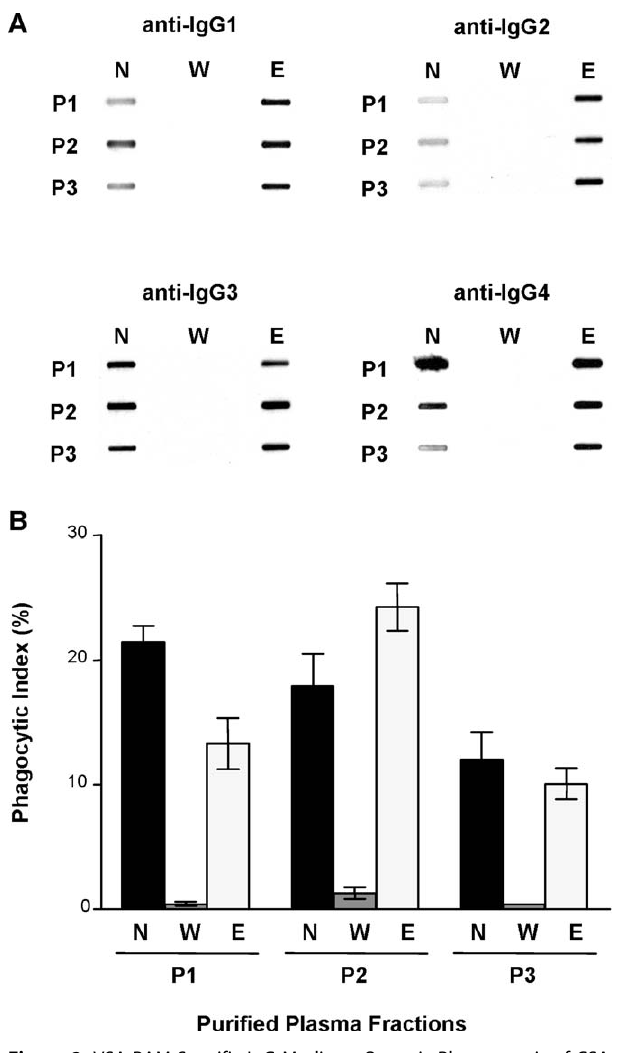
Figure 2. VSA-PAM-Specific IgG Mediates Opsonic Phagocytosis of CSA- Binding Parasitized Erythrocytes (A) Slot blot detection of IgG subclasses in neat plasma (N) and Protein G column-purified wash (W) and eluate (E) plasma fractions. (B) Bar graph showing phagocytic index of plasma opsonized CS2 PEs by murine macrophages. Results are presented as the mean with SD of triplicates ( n ¼ 3) for three MG patients (P1, P2, and P3).